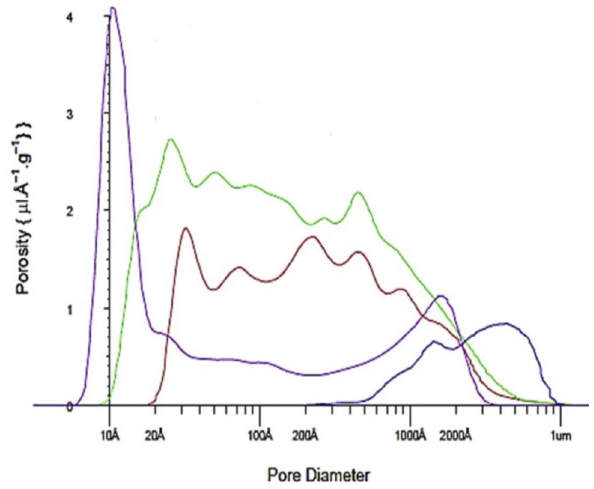
Fig. 25 NMR cryoporometric measurements on four biochars, with different